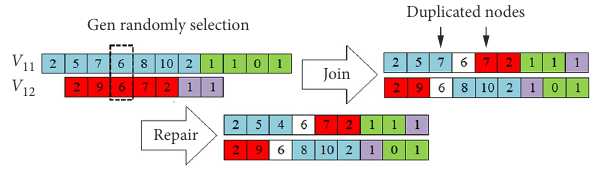
GAFigure 6. Example of the proposed single-point